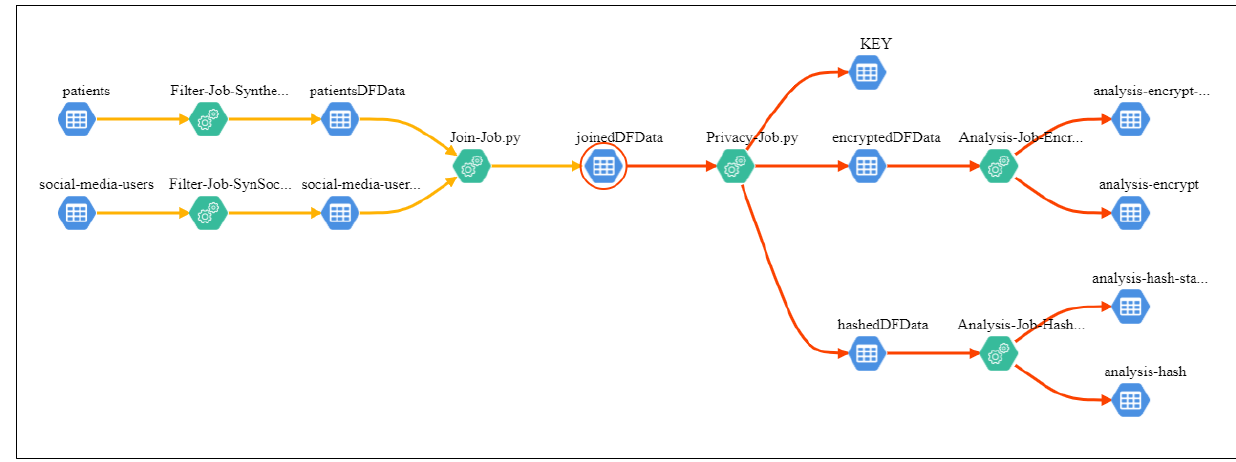
Figure 12. Configuration of data processing and propagation of attribute classification in Atlas. Table 4. Impact of AC security on program execution time.